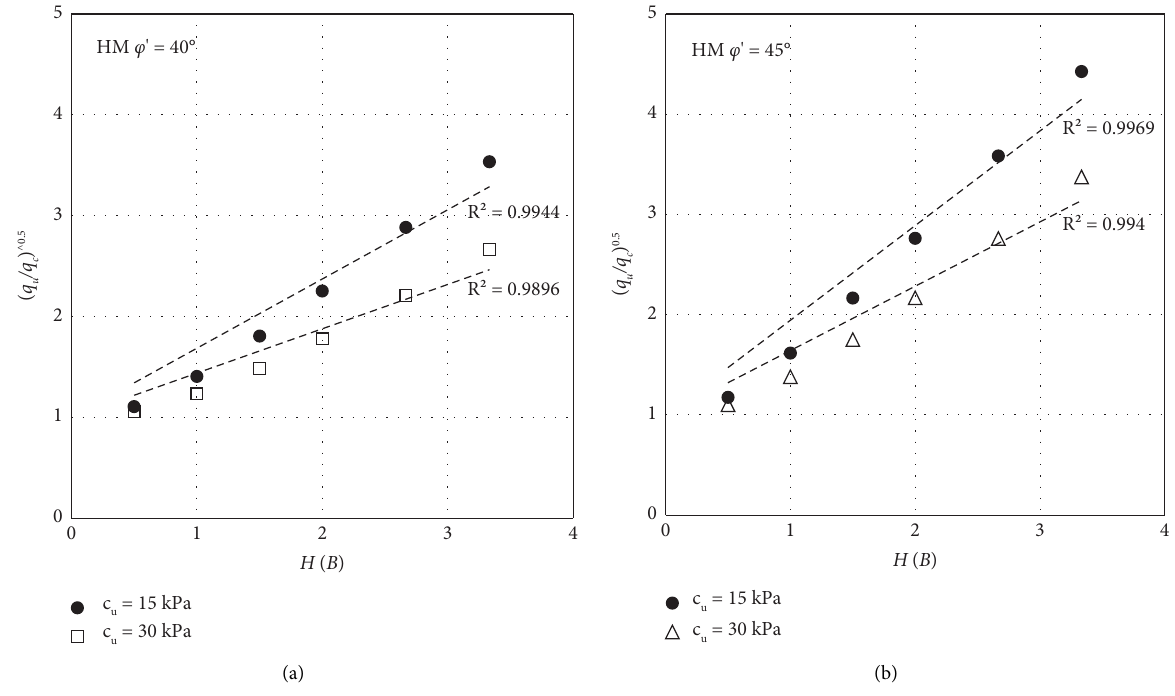
Figure 3: ( q q ) 0 . 5 versus H/B for an unstabilised granular layer (data source: Hannah and Meyerhof [4]): (a) HM ϕ ′ � 40 ° and (b) HM u / c ϕ ′ � 45 °